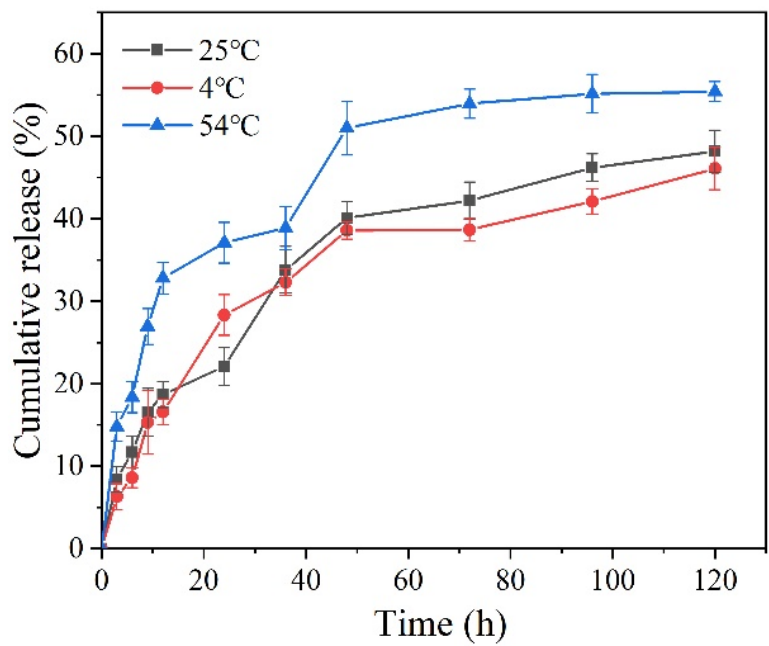
Figure 8. Cumulative release curves of Pro@BMMs-SS-Py/ β -CD NPs at different temperatures.